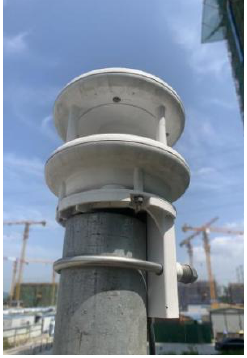
Figure 3. Ultrasonic anemometer.